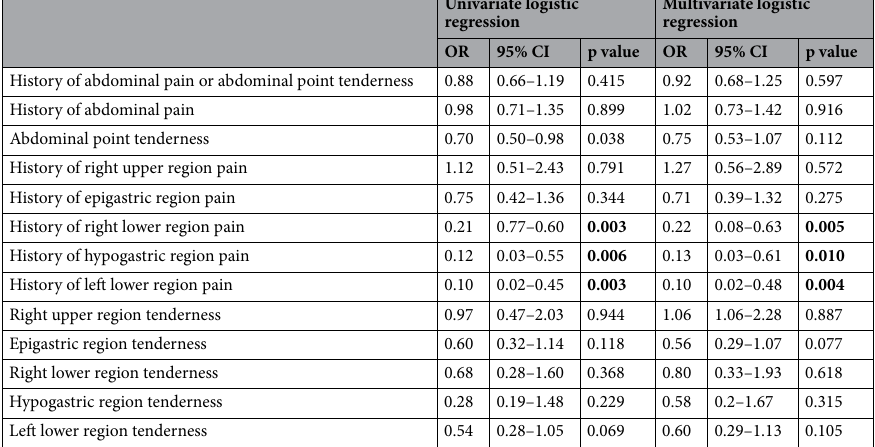
Table 5. Association between dyspnea and abdominal pain pattern in SARS-CoV2 patients, before and after adjustment for sex, age, abdominal surgery during hospital stay (complete case analysis). Each row presented the output of a separate model. OR: odds ratio, CI: confidence interval. Significant values are given in bold.